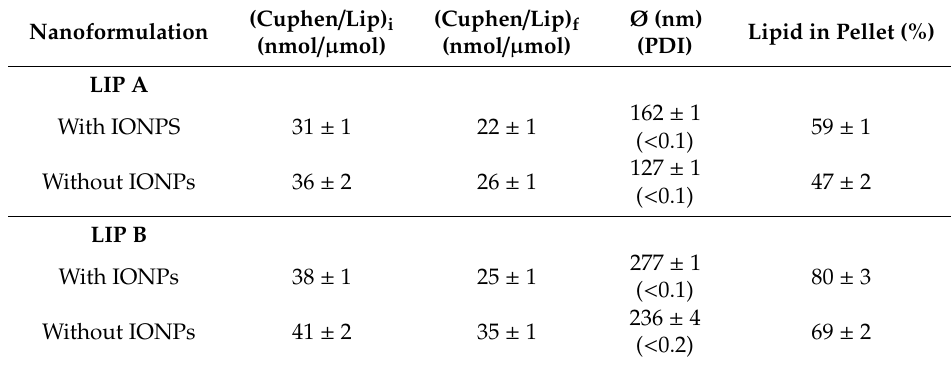
Table 2. Physicochemical parameters of Cuphen liposomes with di ff erent sizes (LIP A and LIP B) in the presence or absence of IONPs.